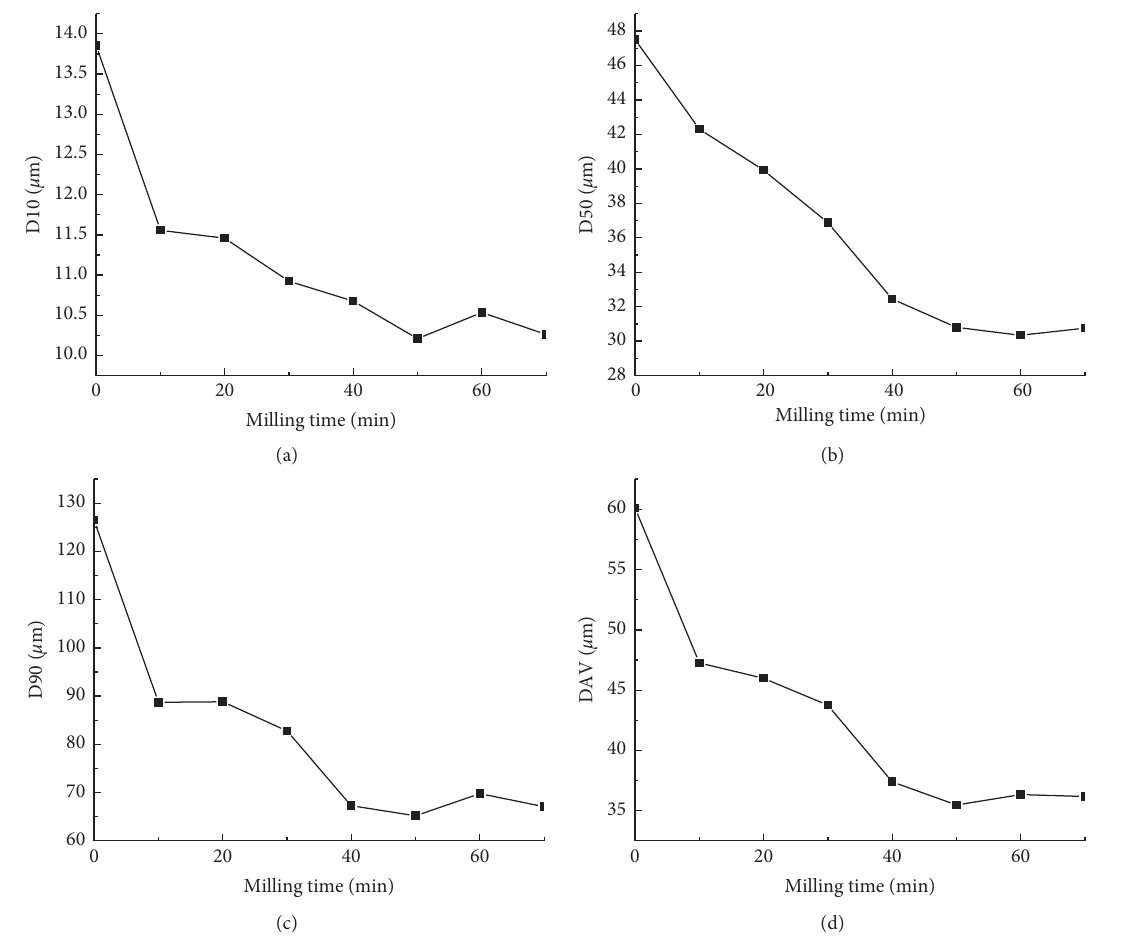
Figure 9: Trend of parameters of particle size of PBG. (a) D10. (b) D50. (c) D90. (d)